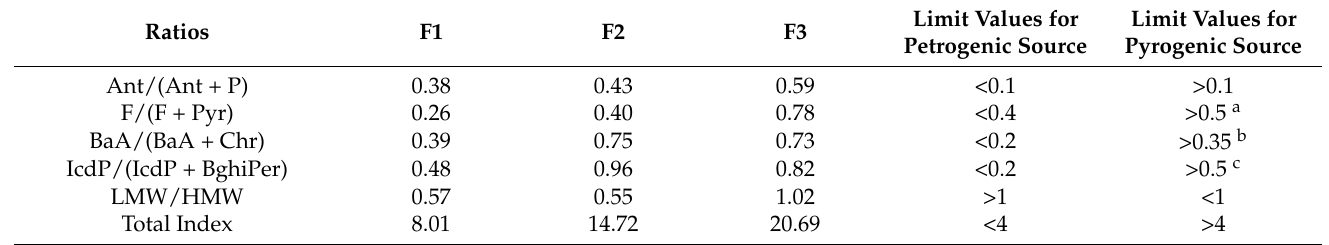
Table 4. PAH diagnostic ratios calculated for the analyzed samples and their limit values, indicating pyrogenic/petrogenic